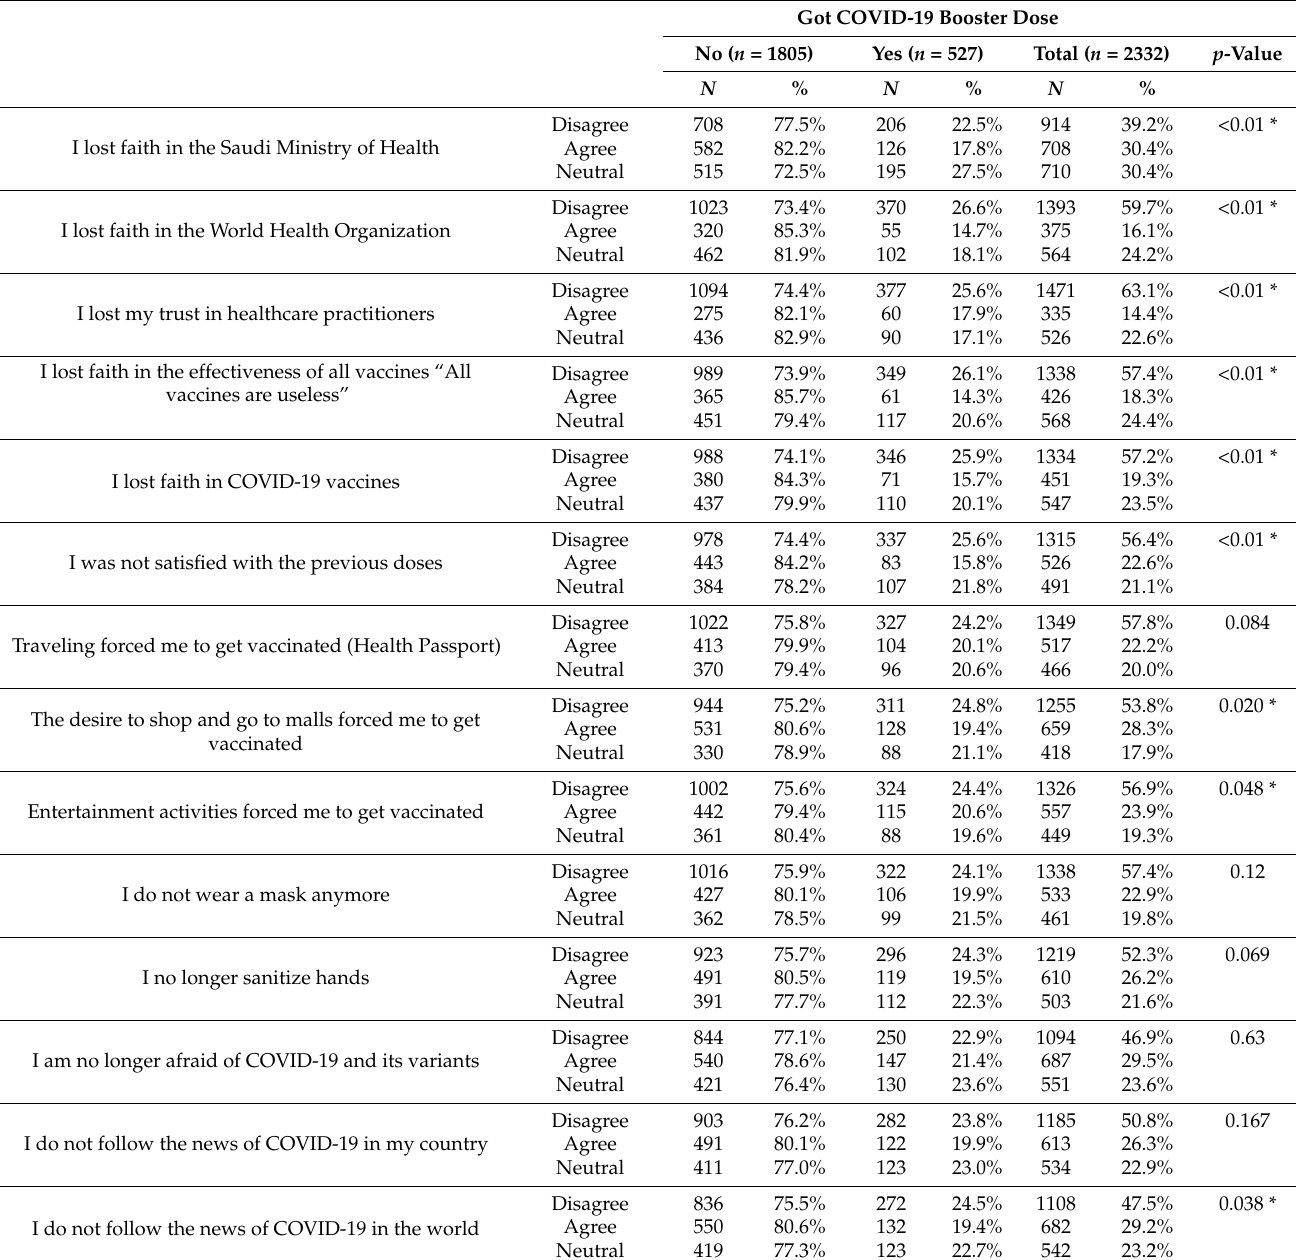
Table 3. Influencing factors of COVID-19 booster dose